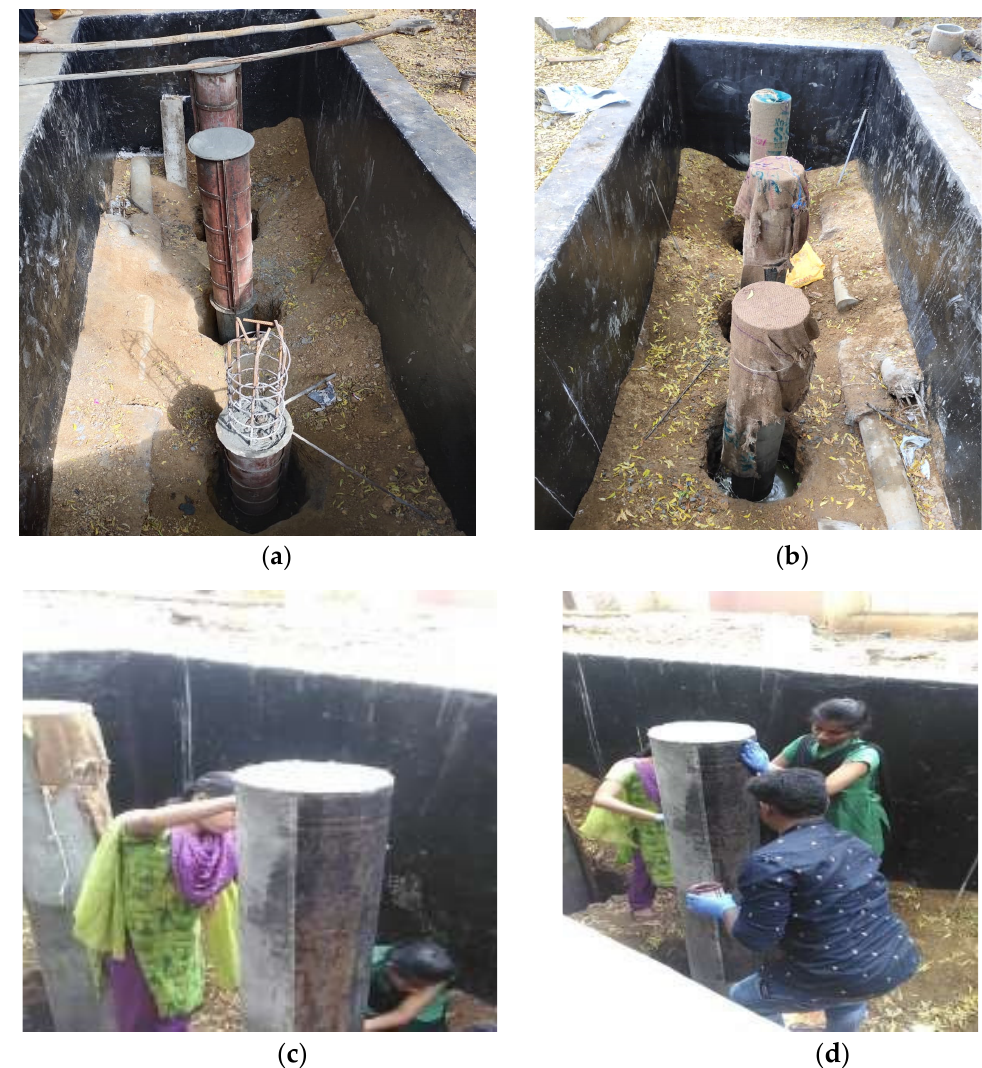
Figure 4. Casting and testing of the FRP-wrapped piles.